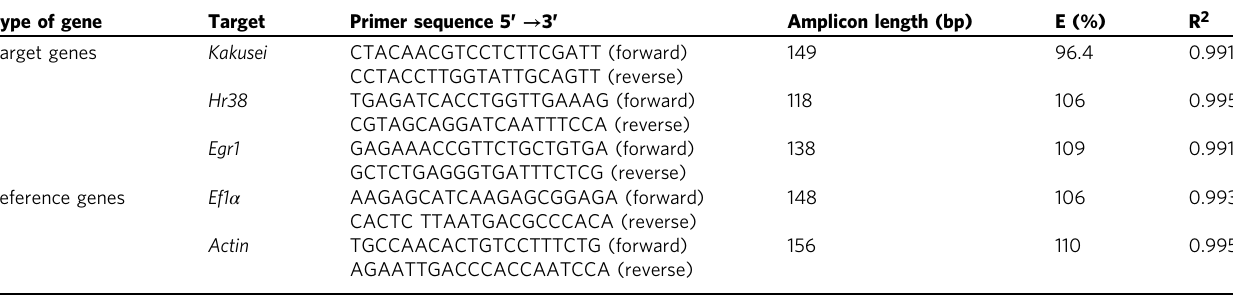
Table 1 Primer sequences used to quantify RNA expression of genes of interest and reference genes by RT-qPCR. Type of